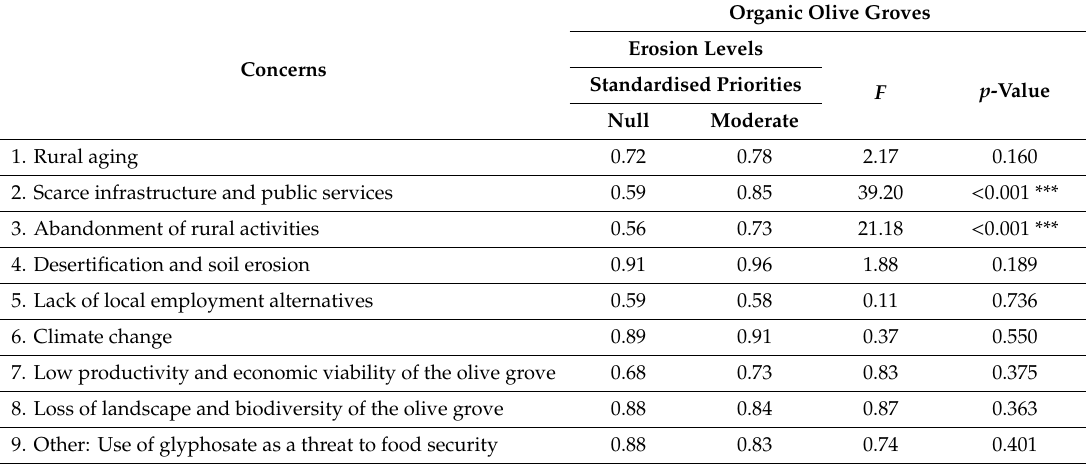
Table 9. Standardised priorities for the main concerns in the olive groves with organic